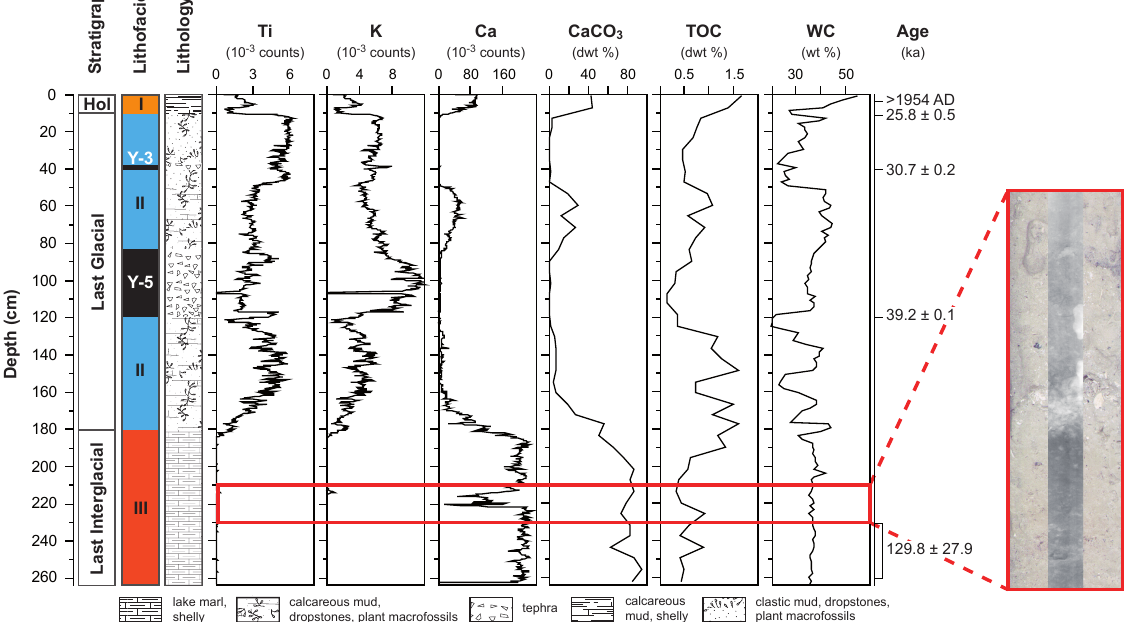
Fig. 2. Rough stratigraphic framework (Hol = Holocene), lithofacies, lithology, Ti-, K-, Ca-intensities, CaCO 3 , total organic carbon (TOC) dry weight percentages, water content (WC), and age control points of core Co1200. The red framed optical and radiographic images to the right show a horizon at 220cm which consisted almost entirely of intact and broken mollusc fossils. Fossil mollusc specimens were solely extracted from the Lithofacies III sediment